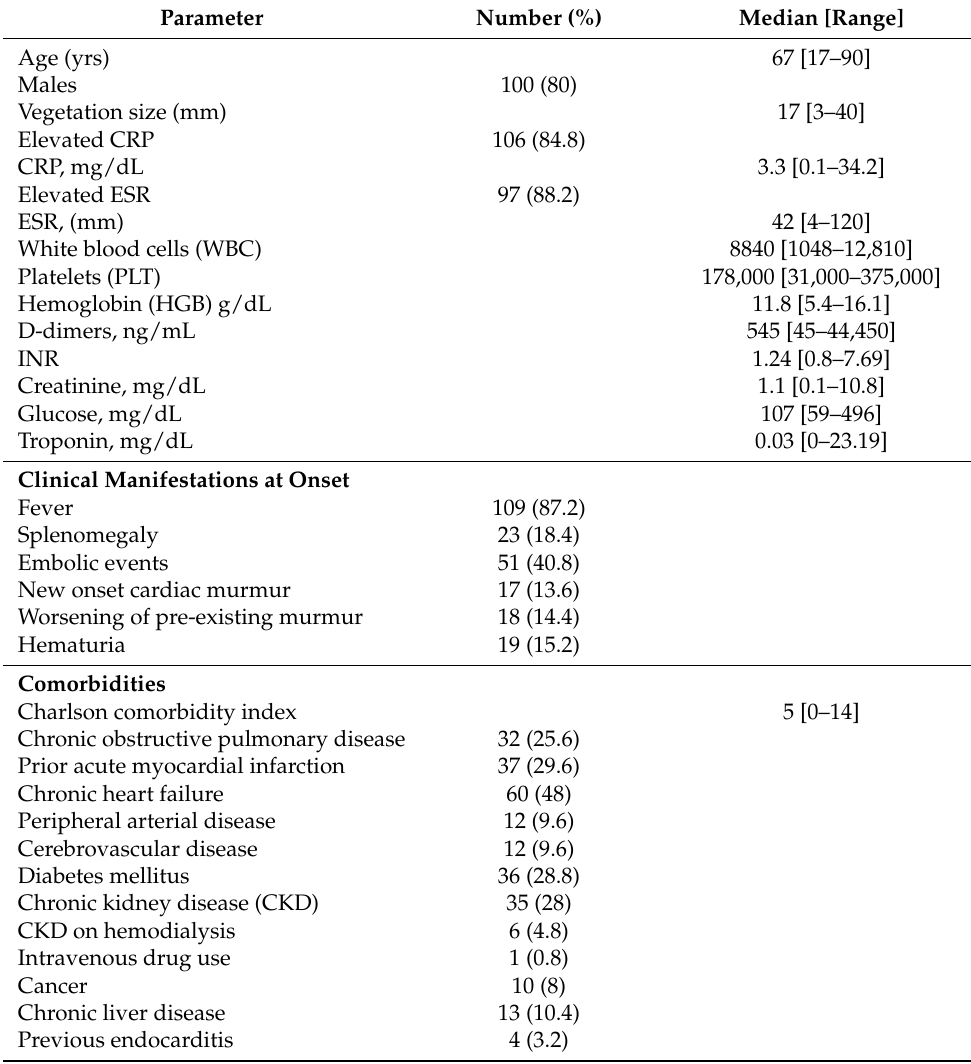
Table 1. Clinical and hematochemical parameters of CIED-related IE patients on admission (n =